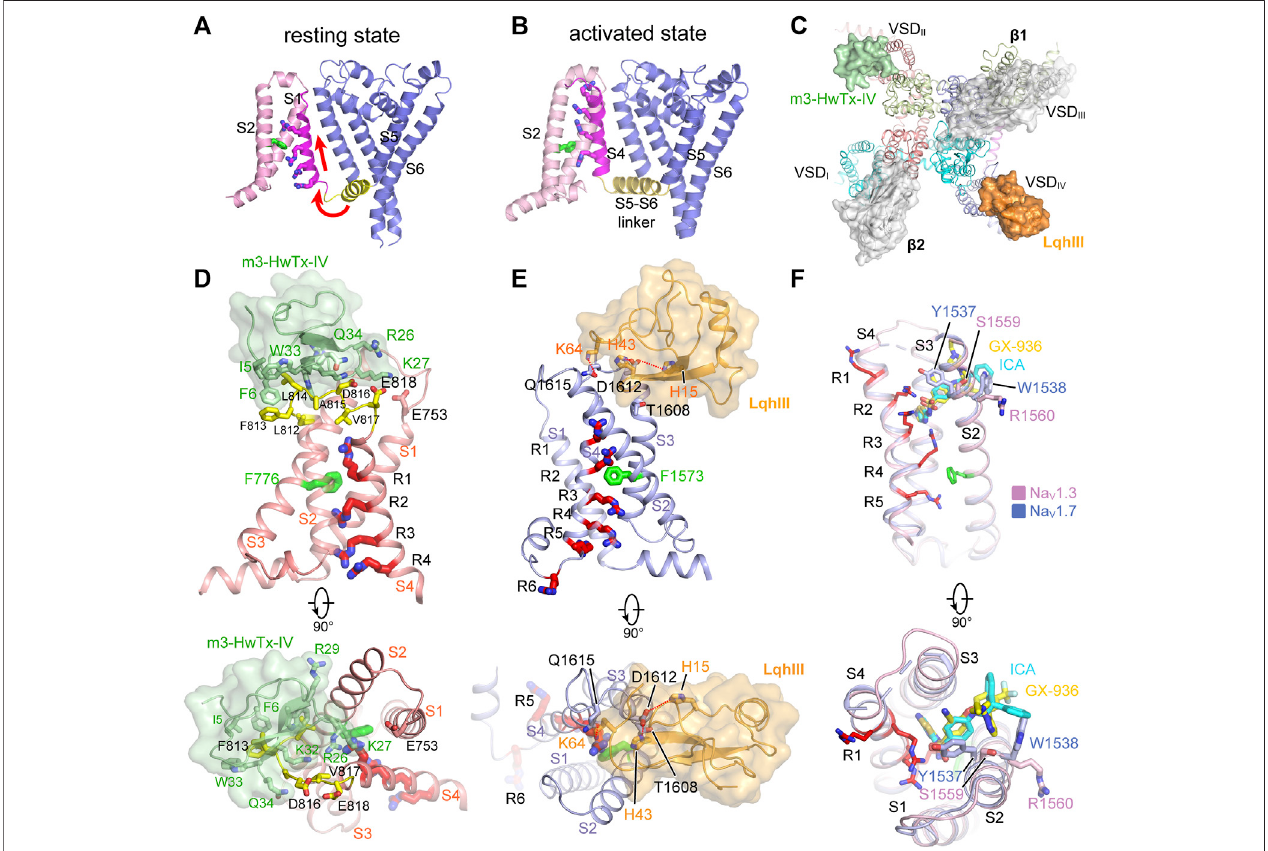
FIGURE5| GMTsbindtoVSDsofNa V channels. (A,B) Resting(PDB code:6P6W)and activated (PDBcode:3RVY)statestructure ofNa V Ab.Redarrows indicate conformationalshiftsbetweenrestingandactivatedstateNa V Ab.ThegatingchargesontheS4helixshownsidechainsinsticks. (C) Site-3toxinLqhIII(PDBcode:7K18) andsite-4toxinHwTxIV(PDBcode:7K48)bindtoVSD IV andVSD II ofNa V channel,respectively.TheIg-likedomainof β 1and β 2subunitsprojectontheVSD III andVSD I , respectively,whichblocktheaccessibilityforpotentialGMTsbindingtoVSD III andVSD I . (D) Highaf fi nitybindingsiteforsite-4toxinHwTxIVinthedeactivatedVSD II (PDBcode:7K48). (E) Detailedbindingsitefor α -ScorpiontoxinLqhIIIinthedeactivatedVSD IV (PDBcode:7K18). (F) Detailedbindingsiteforarylsulfonamidederivatives ICA121431 and GX-936 in the activated VSD IV of Na V 1.3 (PDB code: 7W7F) and Na V 1.7 (PDB code: 5EK0),